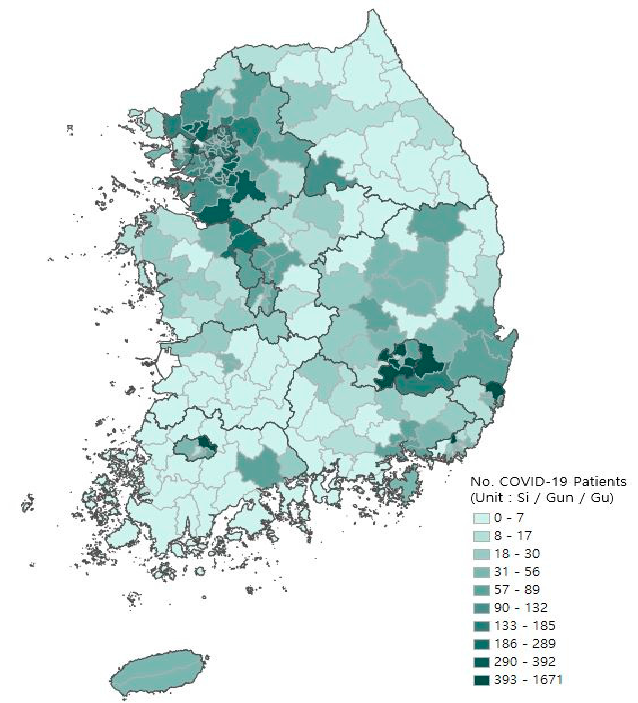
Figure 1. Spatial distribution of the number of confirmed COVID-19 patients at the county level (As of 17 September 2020).